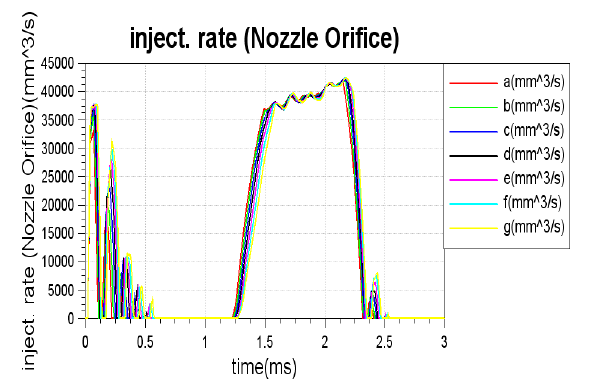
Fig.4 The influence to the fuel injection quantity